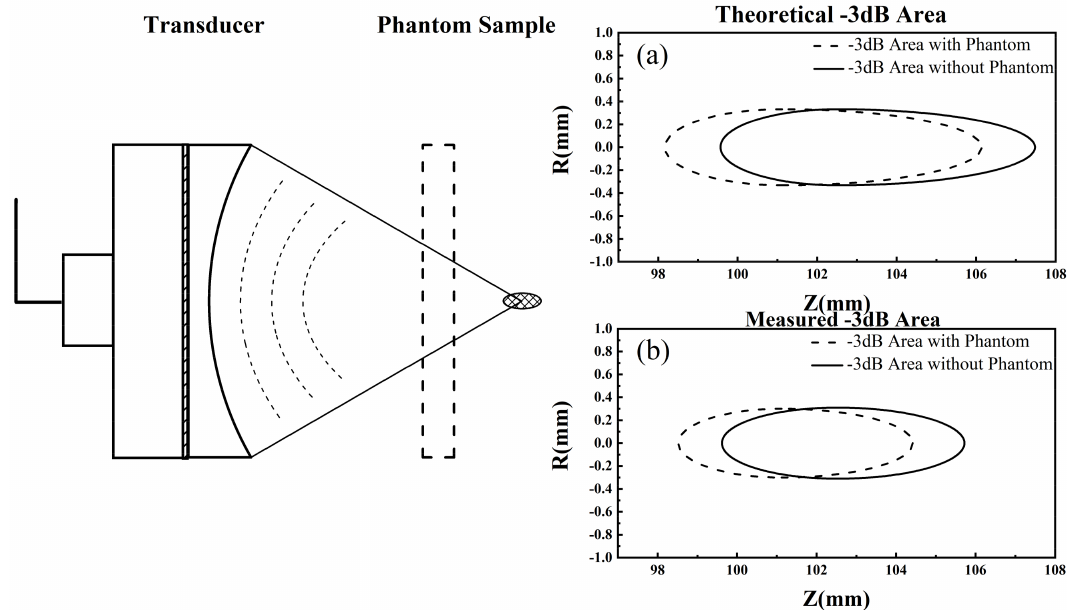
Figure 6. Illustration of the focus shift induced by the presence of phantom sample: ( a ) the theoretical − 3 dB area; ( b ) the measured − 3 dB